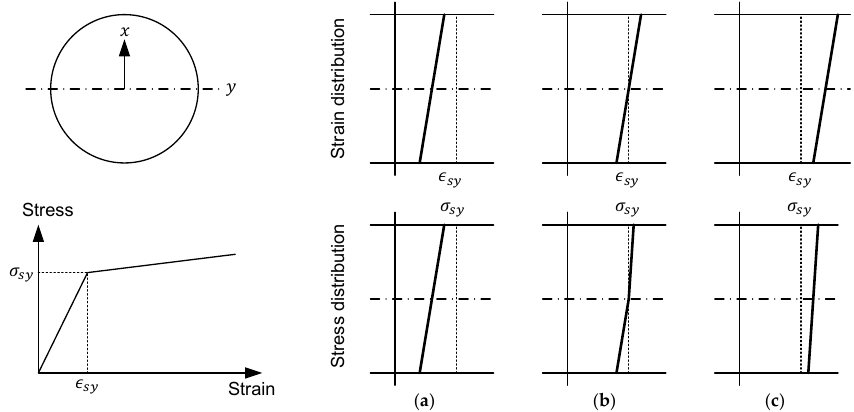
Figure 4. Stress distribution according to strain distribution in the longitudinal direction of helical wire: ( a ) before yielding; ( b ) during yielding; ( c ) after yielding of helical wire.